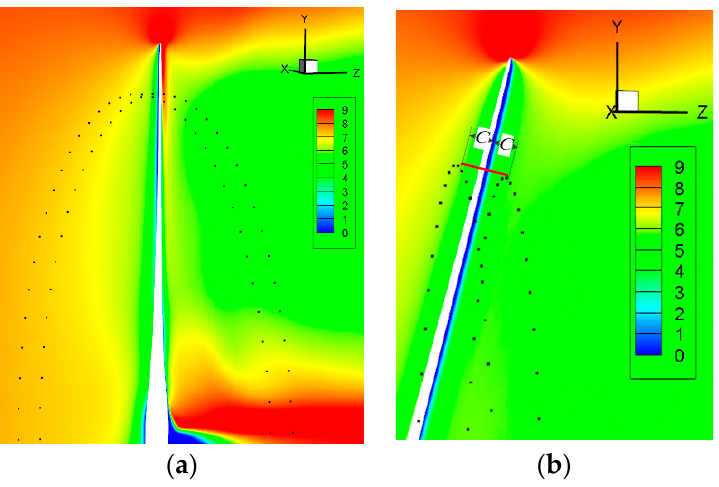
Figure 7. Sketch of points used by AAT to extract AOA: ( a ) straight baseline; ( b ) coned rotor.